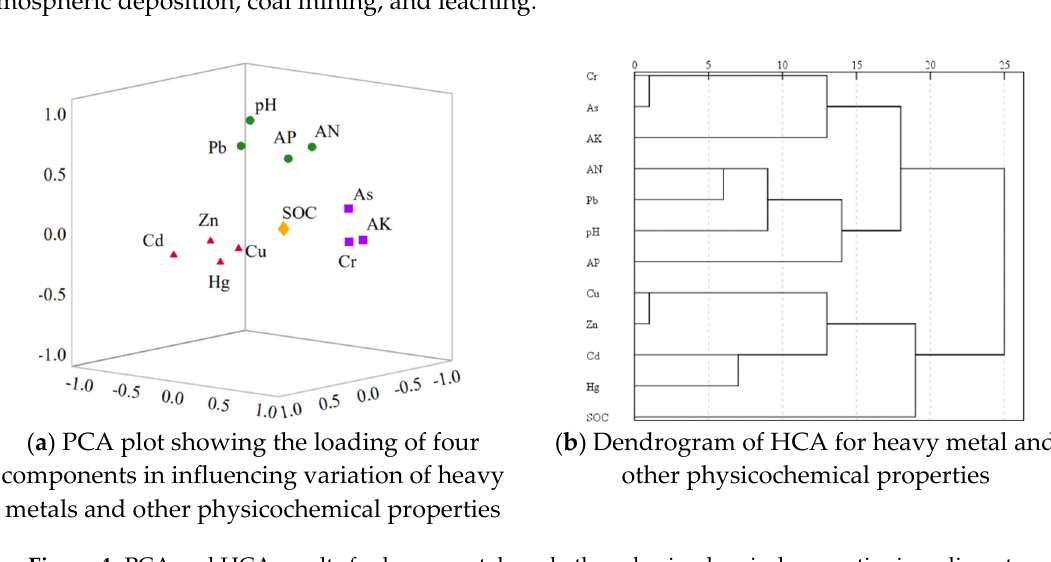
Figure 4. PCA and HCA results for heavy metals and other physicochemical properties in sediments.